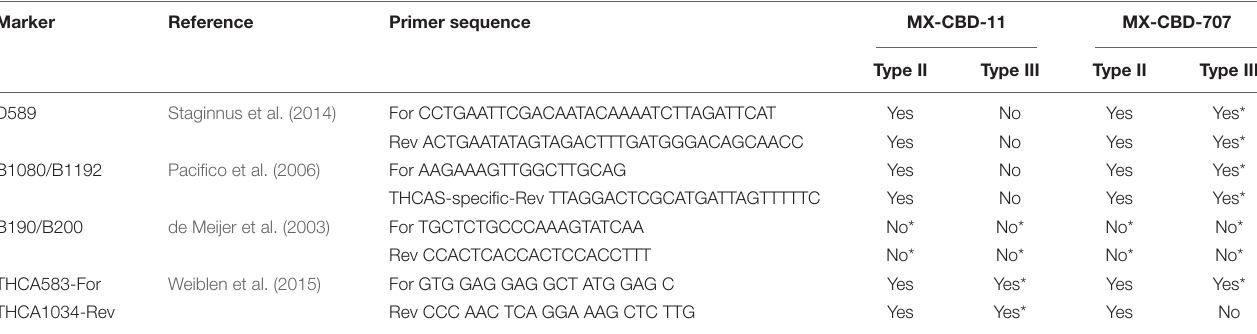
FIGURE 3 | Alignment of THCAS sequences from 24 cannabis plants of the MX-CBD-11 and MX-CBD-707 breeding populations with ClustalW. The provenances of the sequences are indicated with the name of the breeding population, the plant’s unique code, and the plant’s chemotype. TABLE 3 | Published DNA molecular markers developed for determination of cannabis chemotypes and their applicability to discriminate between different chemotypes of MX-CBD-11 and MX-CBD-707. Marker